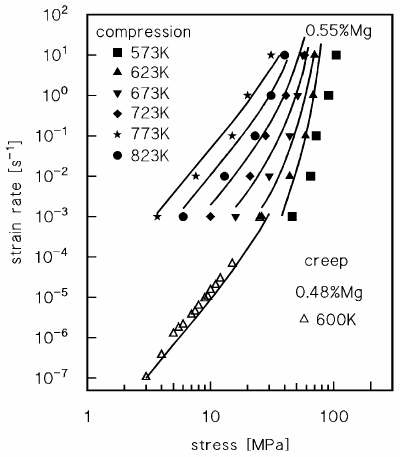
Figure 9. Compression data for 0.55%Mg [28] and creep data for 0.48%Mg [4]. The model curves were calculated by Equations (10)–(11),